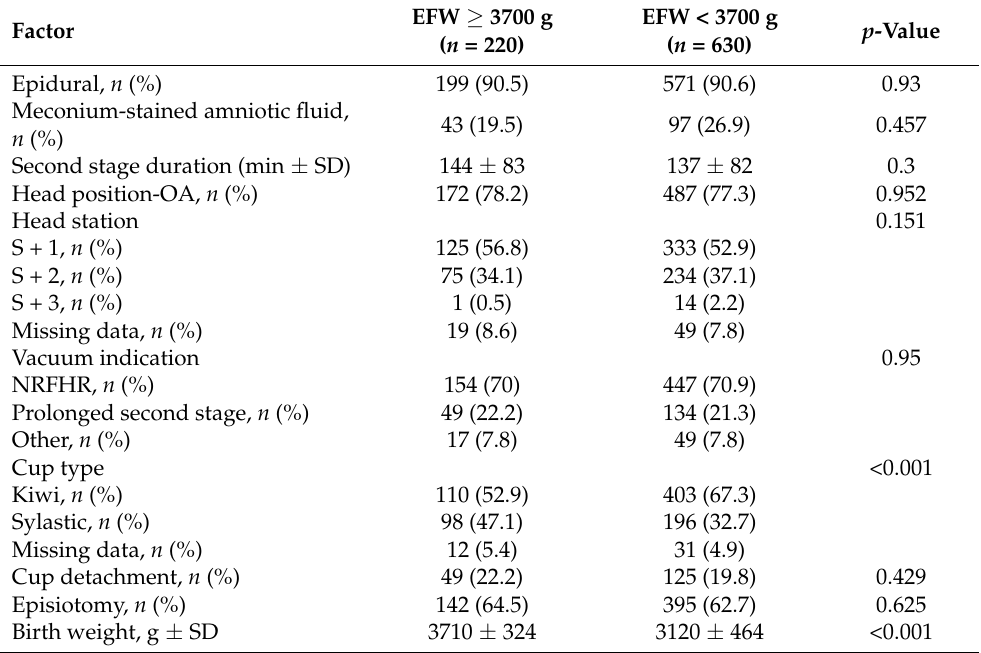
Table 2. Comparison of labor and delivery factors in relation to sonographic